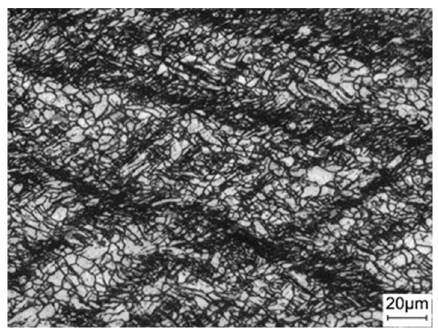
Figure 8. The initial microstructure of Mg strip in the EPR.